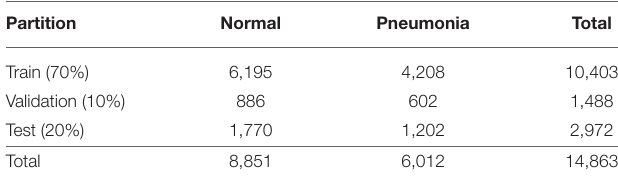
TABLE 1 | Distribution of the images of the used